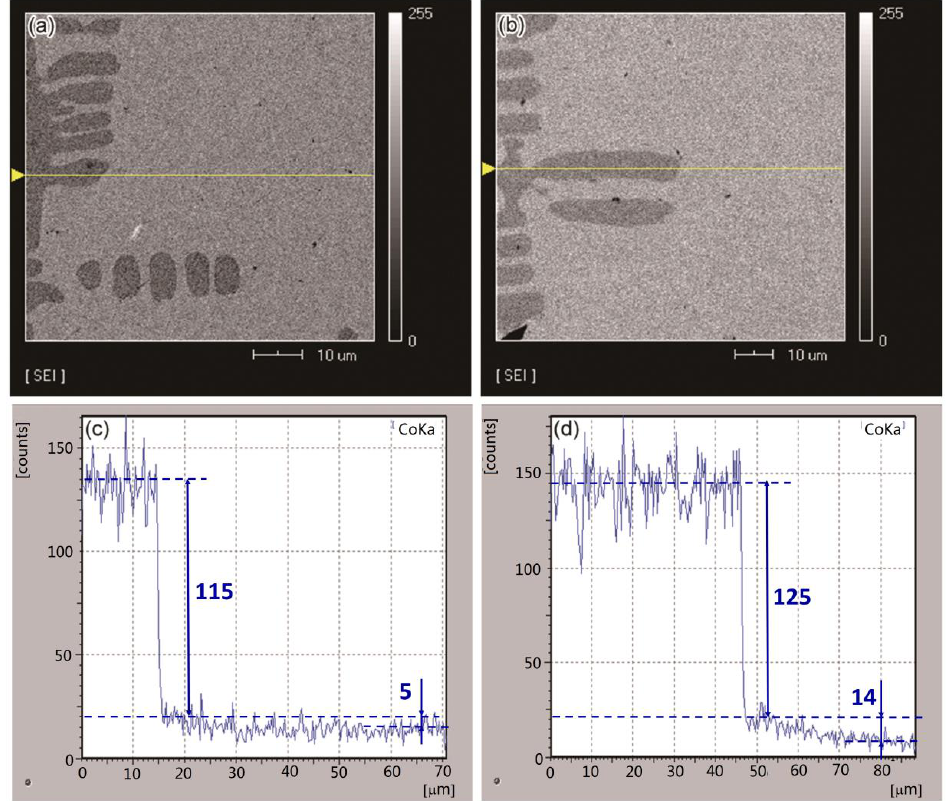
Figure 8. This is a schematic diagram of the EDS line mapping along the Co dendrite arm and extend into the Cu matrix: ( a ) without stirring; ( b ) stirring with current of 200 A; ( c ) and ( d ) is the line mapping results of ( a ) and ( b ) respectively.